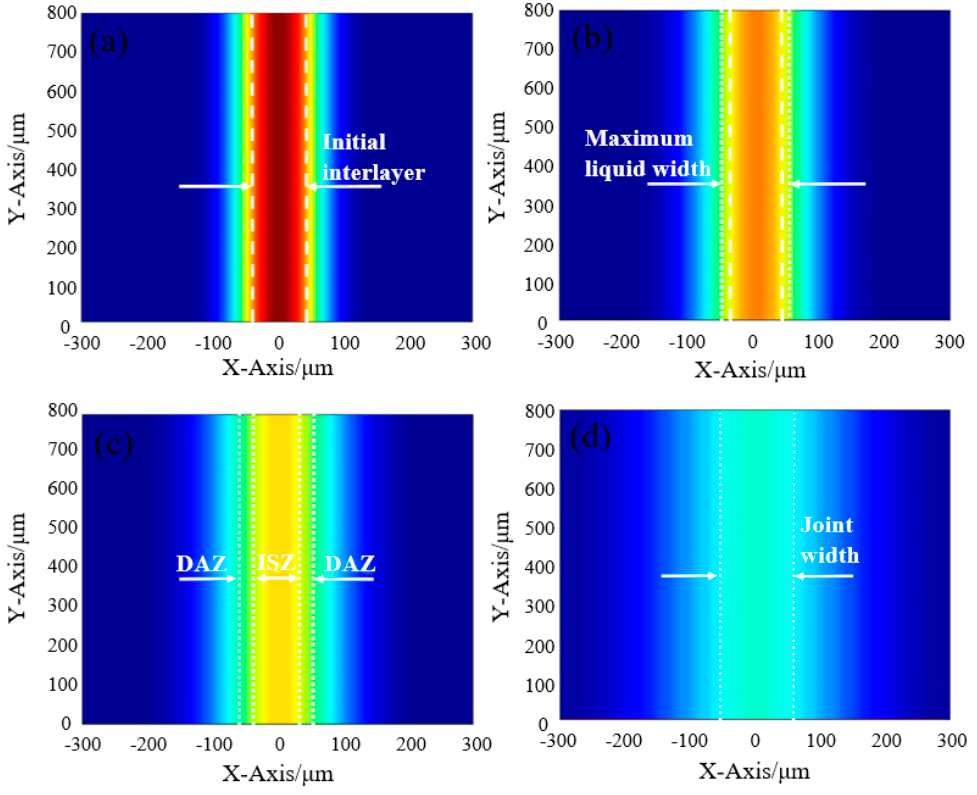
Figure 10. Effect of various durations on the concentration distribution of element at 1160 °C for ( a ) 1 s; ( b ) 10 s; ( c ) 20 s and ( d ) 100 s.